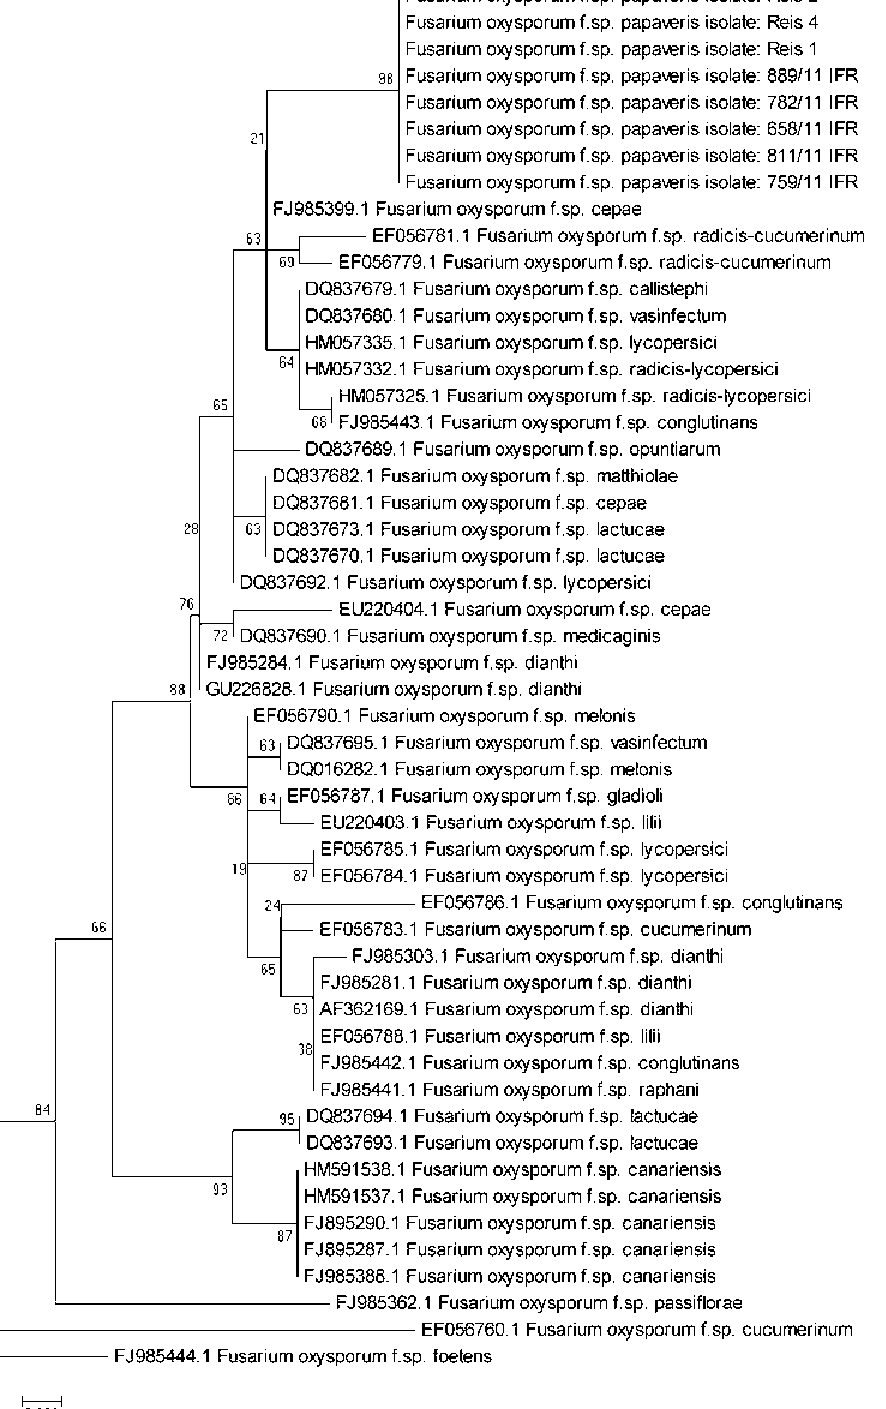
Figure 1. Phylogenetic tree based on EF-1α gene sequences built by Mega5 software with Neighbor joining method; boot- strap values from 1000 replicates are shown at the